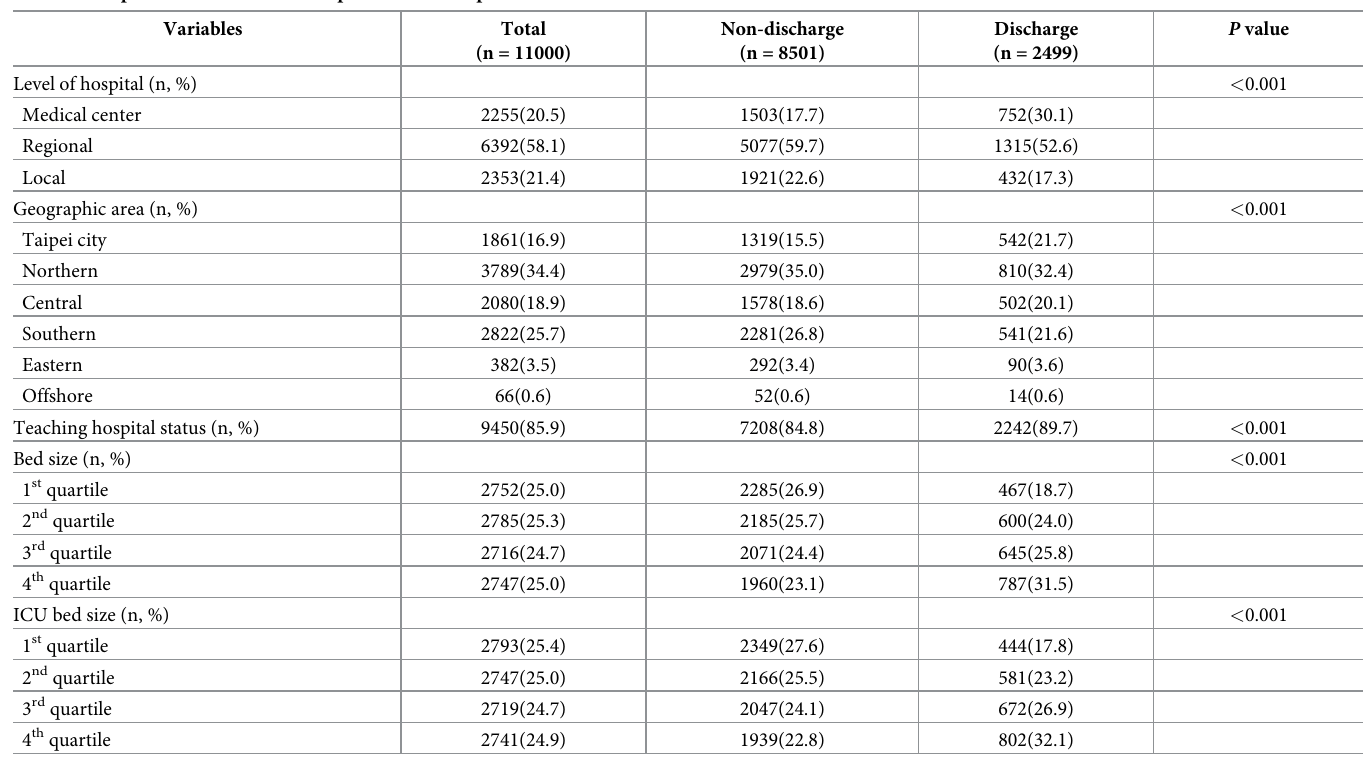
Table 2. Hospital characteristics of hospitalized OHCA patients.